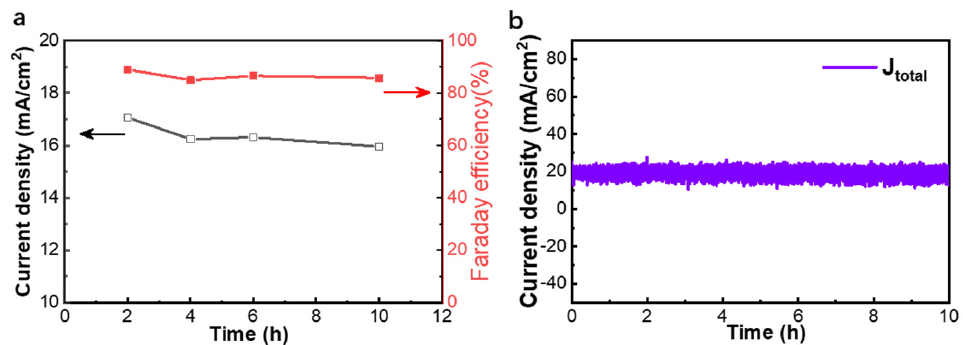
Figure 5. Stability test of the Bi 2 O 2 CO 3 @Bi/CP electrode evaluated at − 1.07 V vs. RHE in a CO 2 saturated 0.5 M KHCO 3 electrolyte by a flow-cell reactor. ( a ) partial current densities of HCOOH (j HCOOH ) and FE during the test; ( b ) the real-time current density of the test.